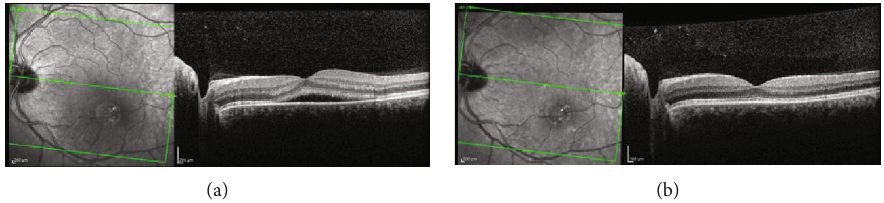
Figure 13: Central serous chorioretinopathy treated with eplerenone. A 44-year old Hispanic male presented with distortion in left eye although visual acuity was 20/20. He reported symptoms for three months. (a) Optical coherence tomography (OCT) con fi rmed subretinal fl uid. The patient was started on eplerenone 25mg daily. (b) One month after starting treatment, OCT showed resolution of the subretinal fl uid. Subjectively, the patient reported